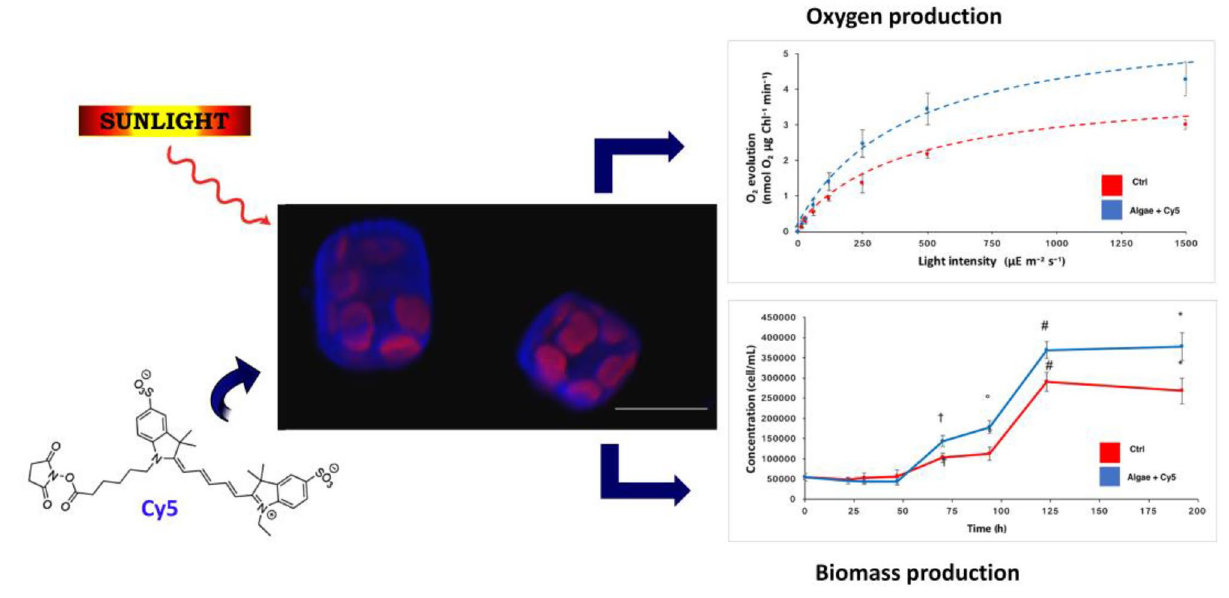
Figure 1. Effects of in vivo incorporation of the Cy5 antenna dye in Thalassiosira weisflogii diatoms. Scale bar of the confocal diatoms micrograph: 10